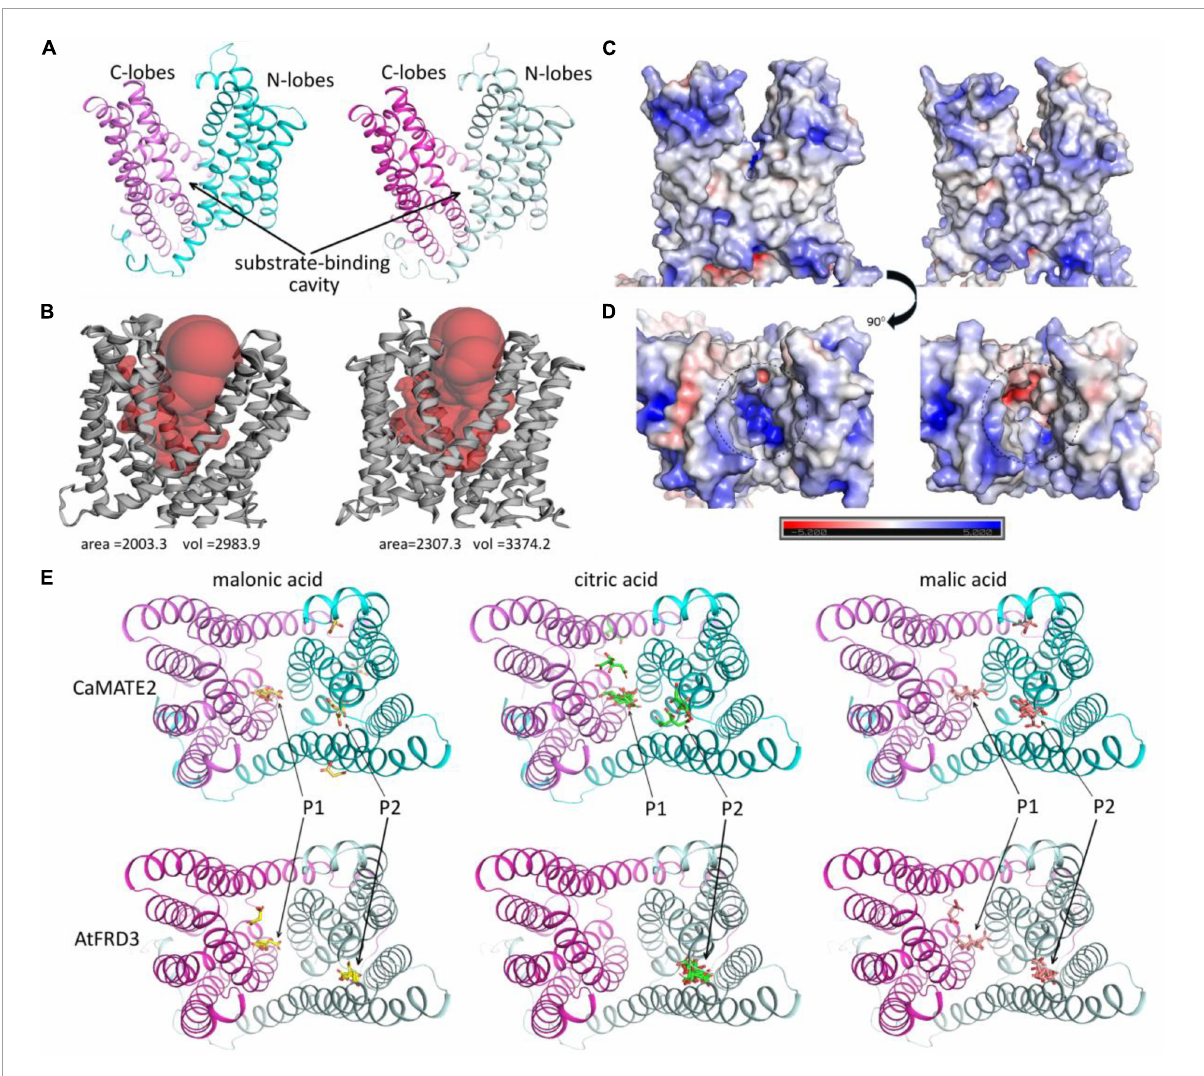
FIGURE7 Protein structural modeling and substrate docking for CaMATE2 and AtFRD3. (A) Overall 3D structures of CaMATE2 (left) and AtFRD3 (right). The N-lobes and C-lobes were colored in cyan and pink, respectively. (B) Display substrate binding cavity. CaMATE2 (left) and AtFRD3 (right). (C , D) Display the electrostatic profiles. CaMATE2 (left) and AtFRD3 (right). (E) Substrate-docking of malonic acid (yellow), citric acid (green), and malic acid (red) to modeled CaMATE2 (top panel) and AtFRD3 (bottom panel). Positions P1 and P2 indicate two major substrate binding